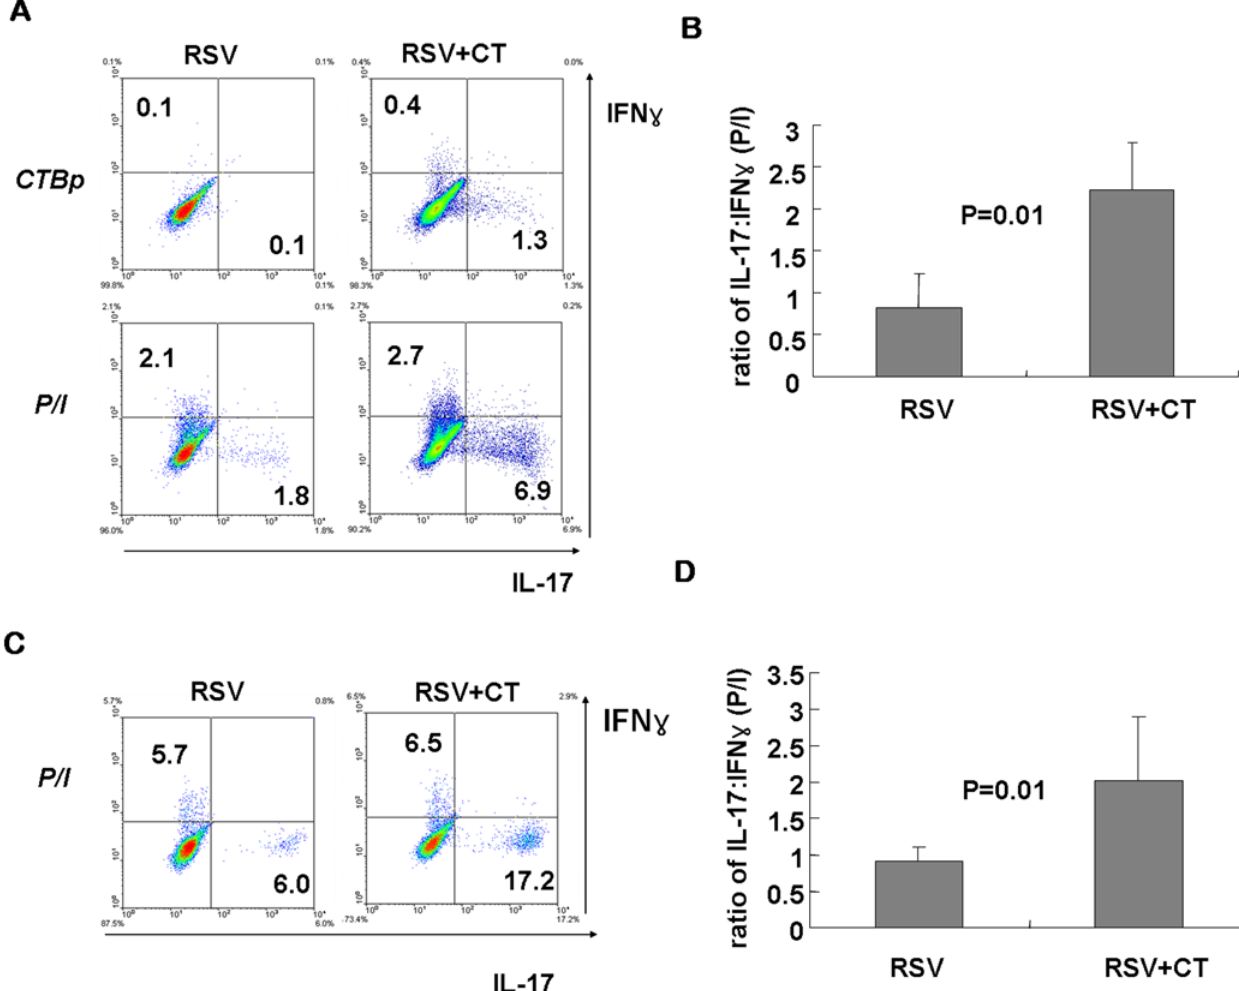
Figure 3. Th17-driving ability of CT upon pulmonary RSV infection in B6 and BALB/c mice. (A) B6 mice were intranasally infected with live RSV together with PBS or CT. At day 7 after infection, lung tissues were isolated, stimulated with PMA/ionomycin, and stained for CD4, IFN- c , and IL- 17. CD4 + gated cells were shown in the dot plots. (B) The graph represents the average ratio of IL-17:IFN- c -producing CD4 cells. (C, D) The similar experiments were performed in BALB/c mice. Dot plots are representative of at least two independent experiments and data are average 6 SEM, n=4 , 5 mice per group.